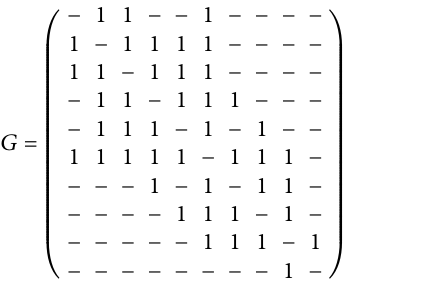
) . The values of usual structural information for networks are given: the probability p i ;thepossiblemaximumnumberofdifferentwedges, ( d ] i